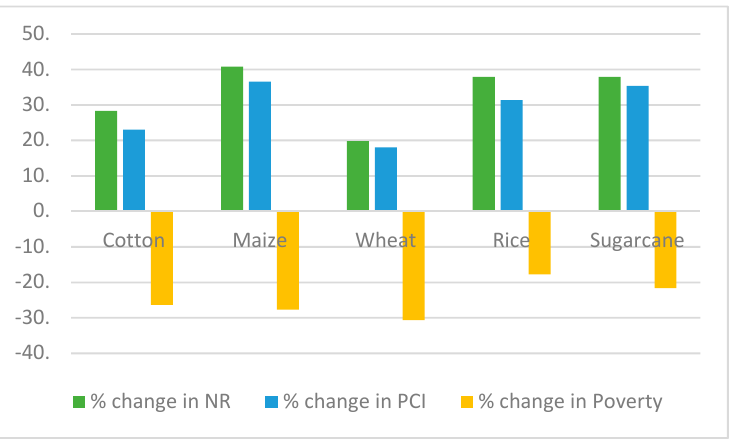
Figure 10. Impact of the adoption of HEIS on net farm returns, per capita income and poverty.